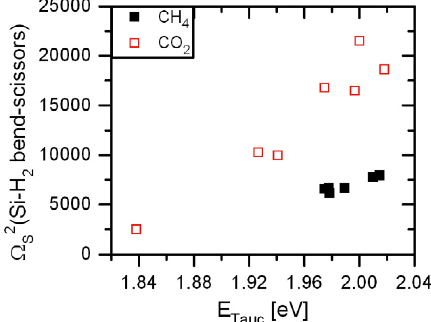
Fig. 6. Squared oscillator strength of Si-H 2 bend-scissors IR mode at ν = 880 cm − 1 for amorphous silicon alloy single layers produced with CO 2 or CH 4 on c-Si wafers.